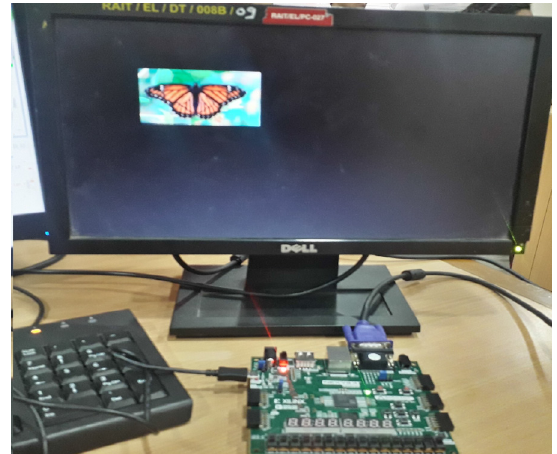
Figure 10. Interfacing of original image with Nexys 4 DDR board. Figure 4. Block diagram of the work.